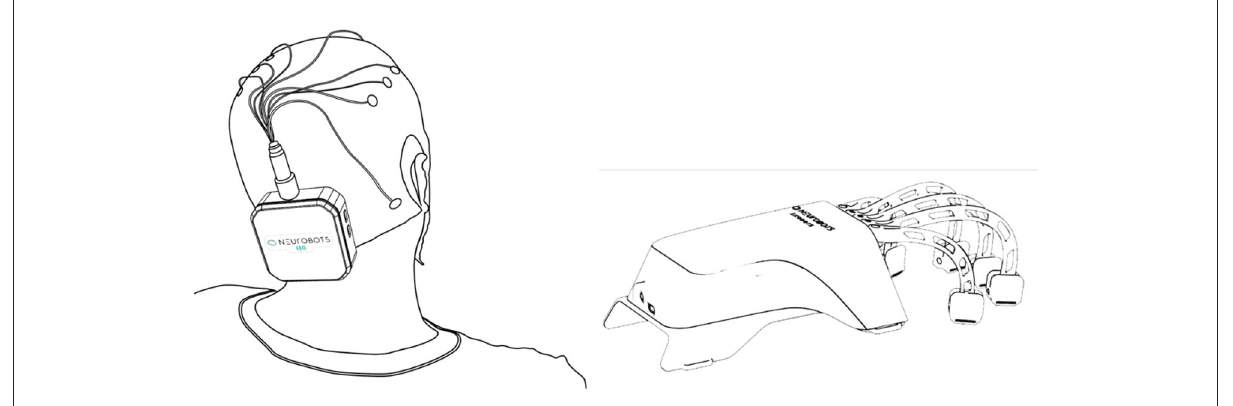
FIGURE1 Schematic drawing of the BCI